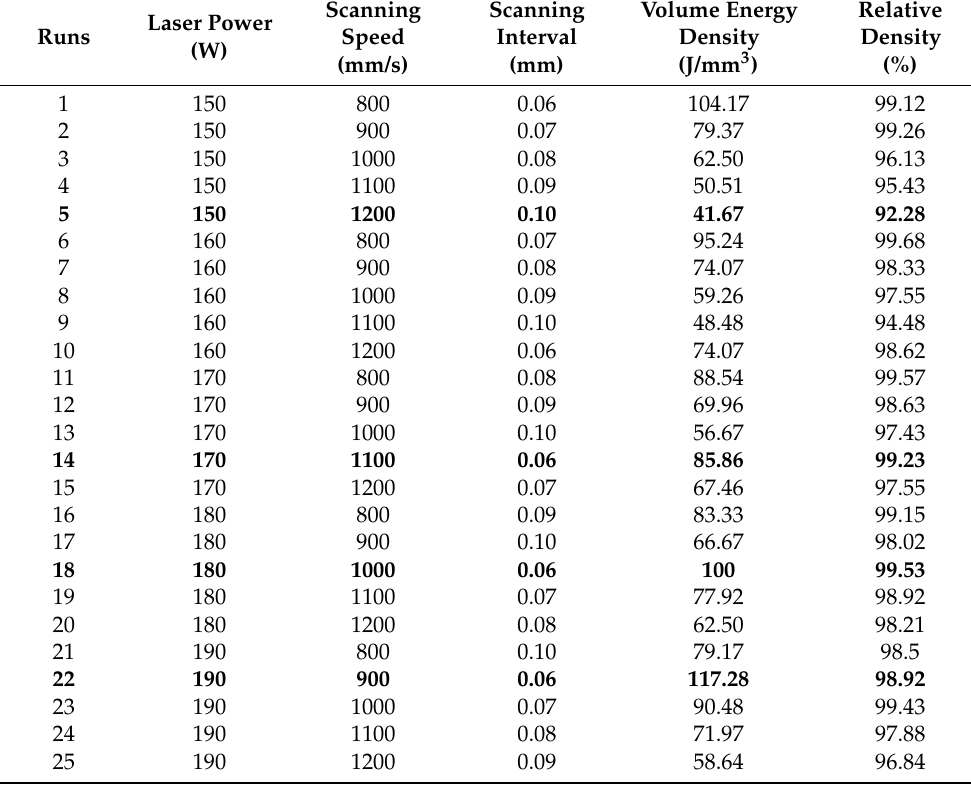
Table 3. Experimental design of L25 orthogonal array and experimental results for relative